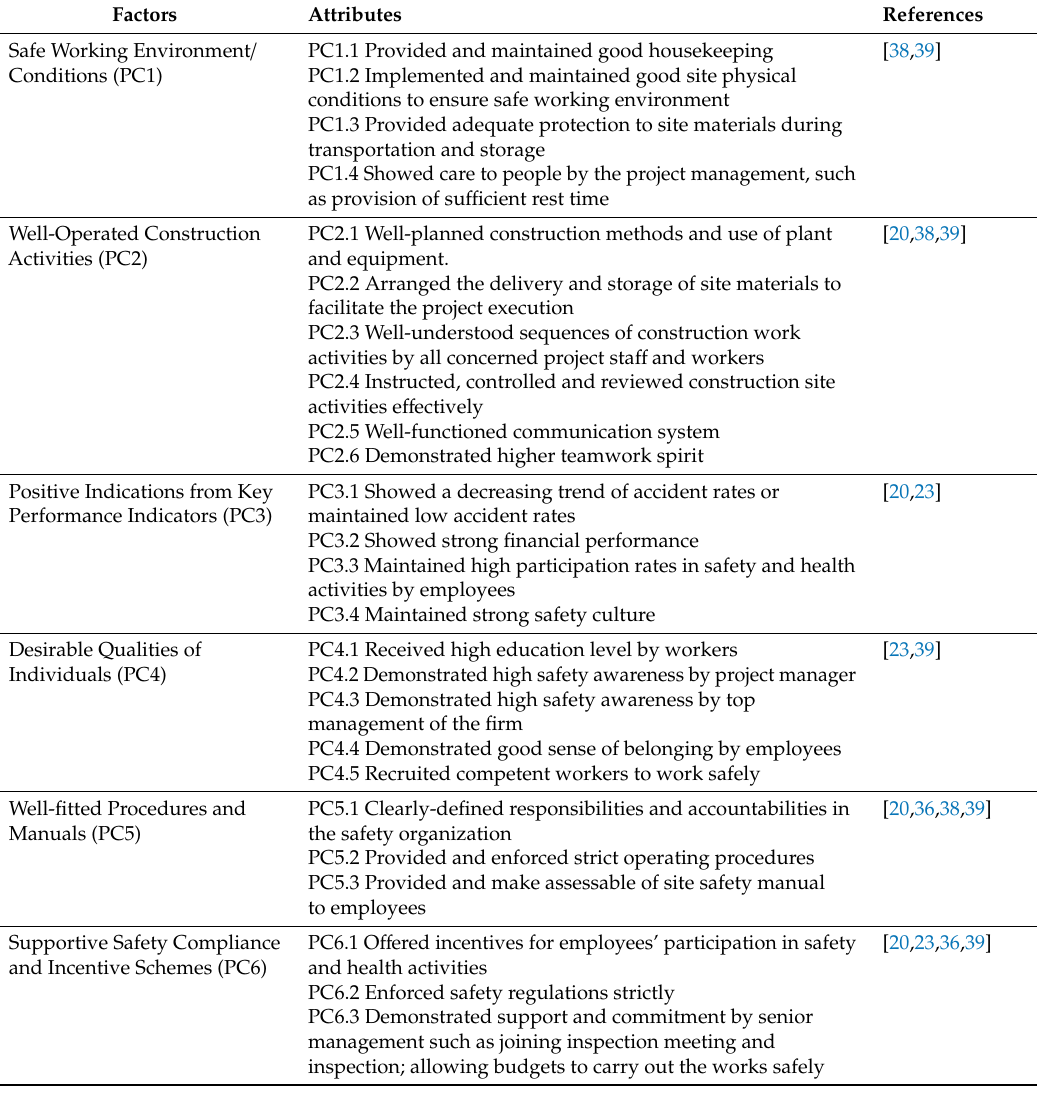
Table 2. Constructs and Initial Measurement Attributes for Project